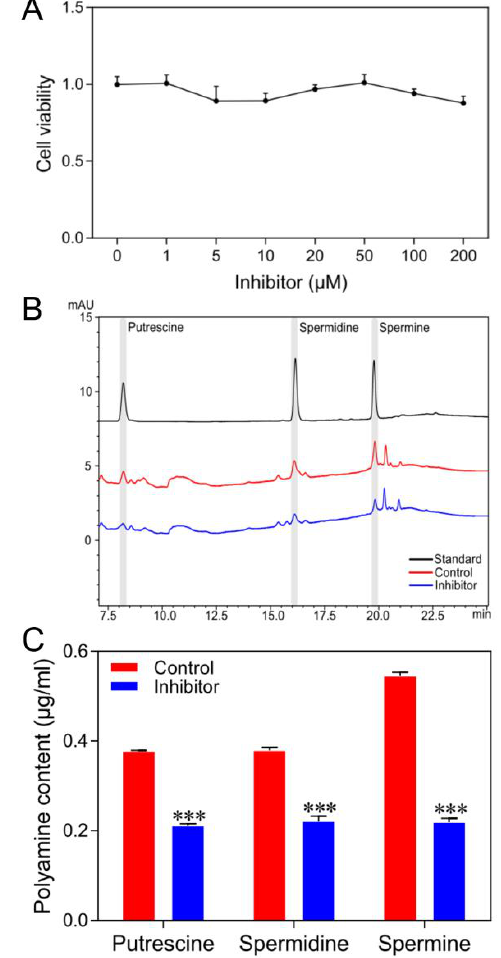
Figure 4. Inhibition of polyamine pathway activity decreases the levels of polyamines in cultured silkworm cells. ( A ) Cytotoxicity test of different concentrations of spermidine on the silkworm cells. ( B ) The standards of various polyamines and intracellular polyamines were determined by HPLC and the representative figure is shown. ( C ) Three independent experiments for polyamine content were analyzed, and the data presented are the means ± SD ( n = 3). For significant analysis: *** p < 0.001.